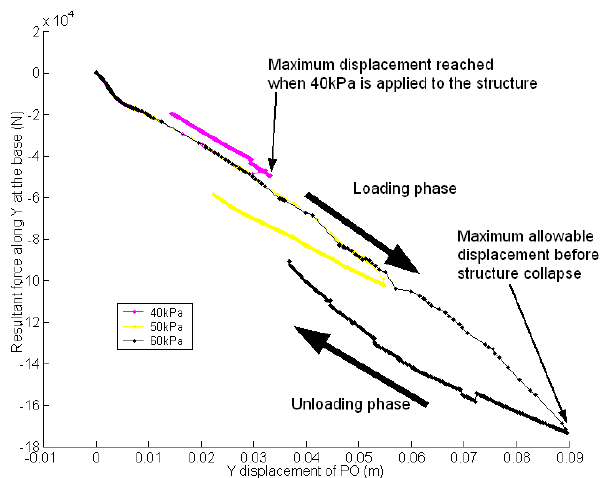
Fig. 13. Exemple of pushover tests for several maximum pressures. Force-displacement curve (imposed